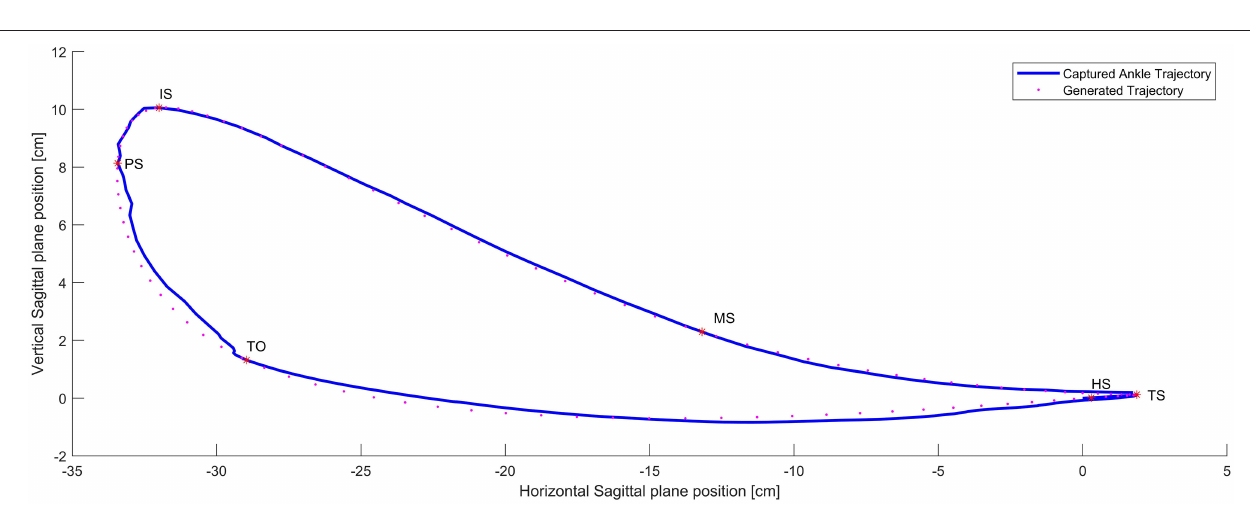
(see Figure 6 ). Both orthogonal axes resulting from the EVD are the axes of maximum variance of the point cloud per event.